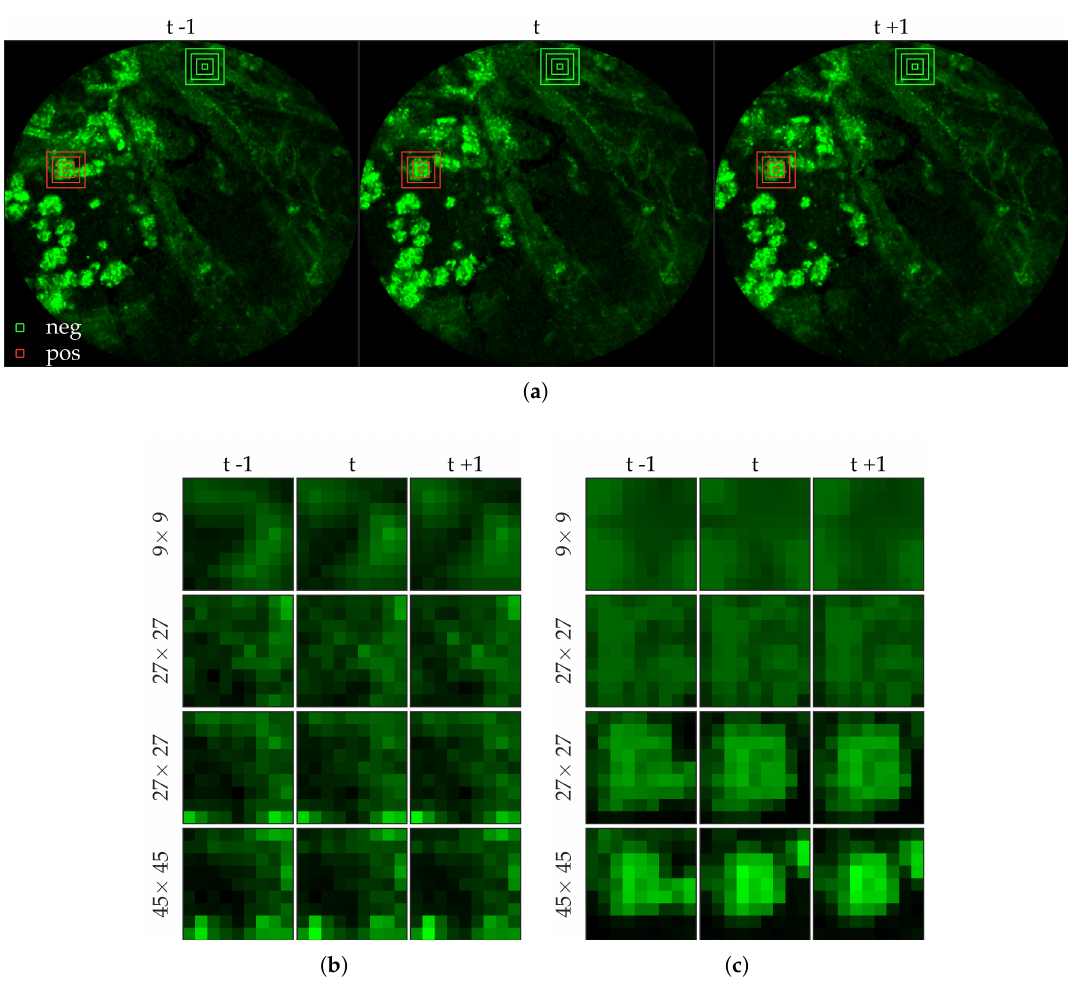
Figure 6. Illustration of spatio-temporal and multi-resolution feature extraction. ( a ) Image patches around positive (red) and negative (green) annotations: the three boxes are of sizes 9 × 9, 27 × 27, 45 × 45 and 63 × 63 pixels respectively; ( b ) Features (neg. sample); ( c ) Features (pos.